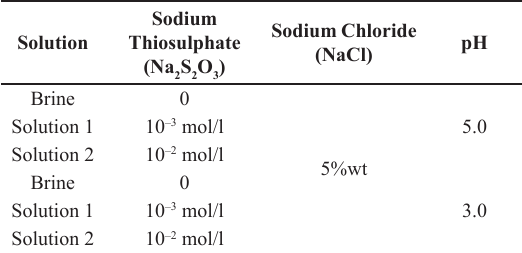
Table 2. Chemical composition of the solutions used in the weight loss